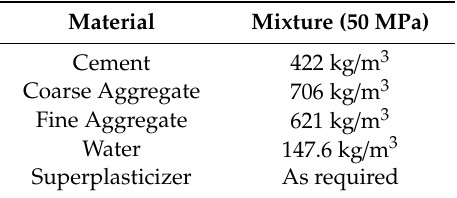
Table 2. Mixture proportions of the